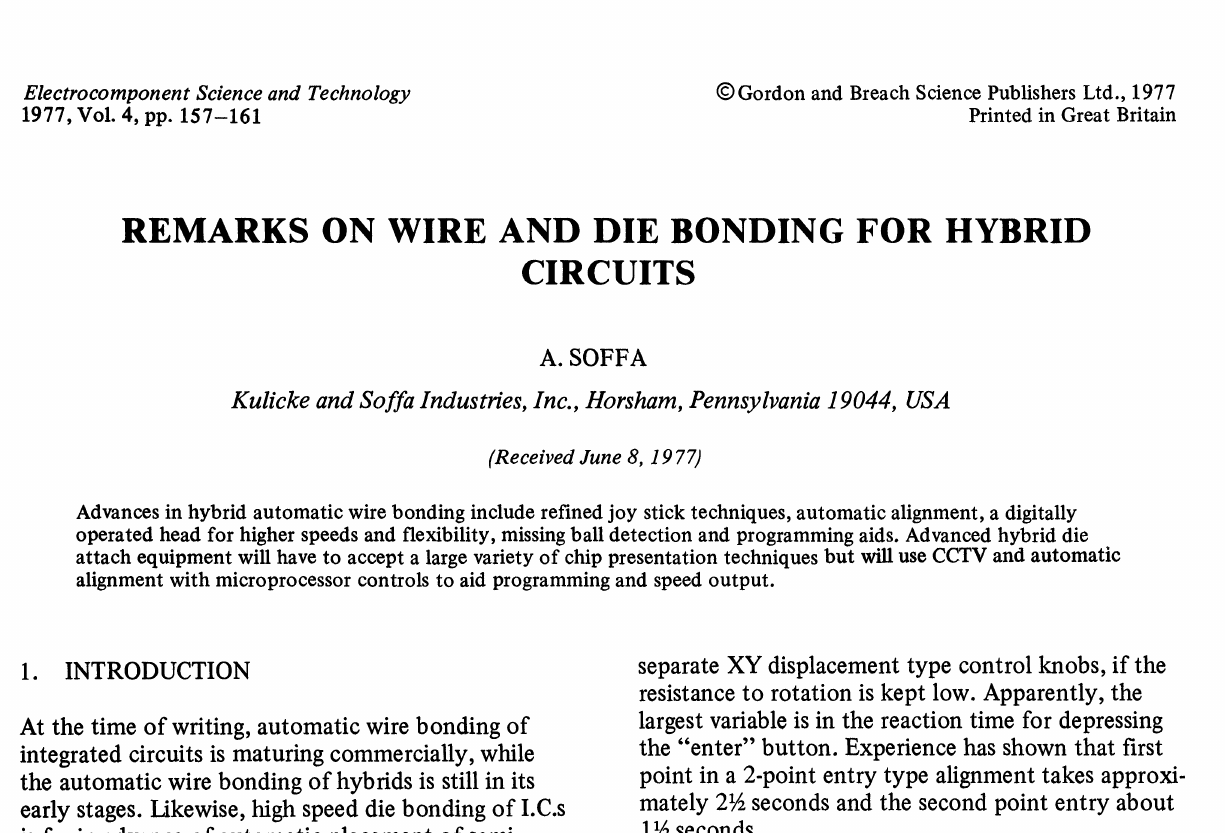
is a curve useful in predicting output rates as a function of time per wire and alignment time. The curves are for 14-lead I.C.s with approximately aA second per I.C. allowed for all indexing and settling times. It shows that wire bonders, in the .450 sec./ wire rate will yield approximately 325 units/hour with a 4 sec. operator-controlled alignment time. However, tests in the field with fully automatic alignment as associated with the K&S Model 1414 Wire Bonder 2 with average alignment times of approximately 1/2 sec. achieved rates of over 450 units/hour. Figure 2 is a plot of acquisition time data, including movement between two points and calculation time as a function of error of displacement. This data shows the advan- tage of having die placement errors of less than + 5